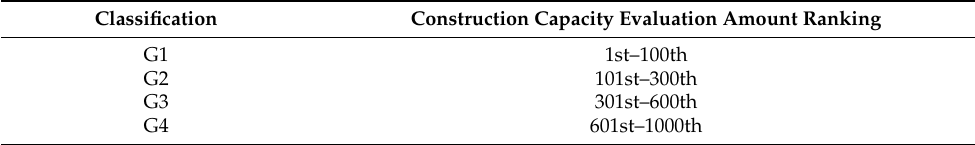
Figure 2. System evaluation and PQ process. Table 1. Classification criteria for evaluation targets.